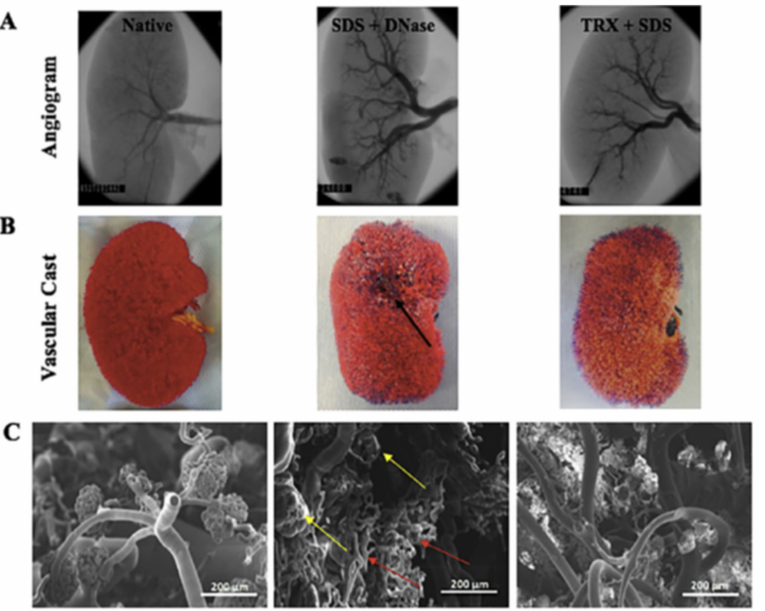
Figure 2. Comparison of vascular microarchitecture of native versus decellularized kidney scaffolds formed as a result of SDS and DNASE and triton X and SDS treatment. ( A ) Fluoroscopic angiogram images, ( B ) vascular casting, and ( C ) SEM images of the vascular cast (50 and 150 × magnification). Defect areas (black arrow) in vascular casts and damaged glomerular structures (yellow arrows) and blood vessels (red arrows) are shown as a result of DNASE and SDS treatment. (Reproduced with permission from Elsevier, adapted from reference